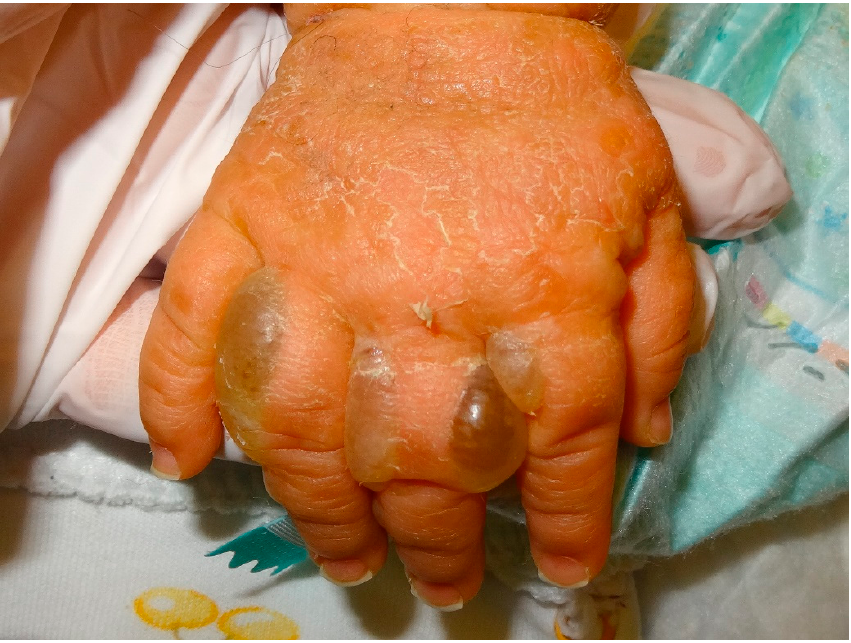
Figure 11. Bullous pemphigoid with typical appearance of bunch of grapes on the hand of an in ‐